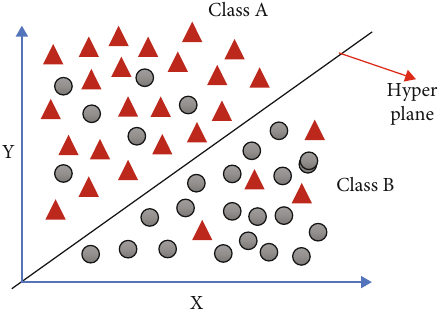
Figure 5: Architectural diagram of